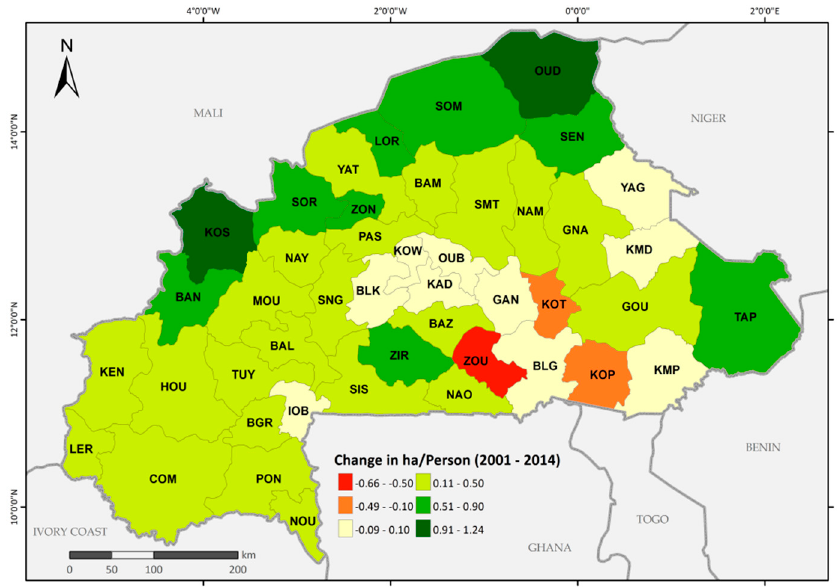
Figure 11. Change of agricultural area (in ha) per person (rural) in the provinces of Burkina Faso between 2001 and 2014; the province names are abbreviated by three letters.